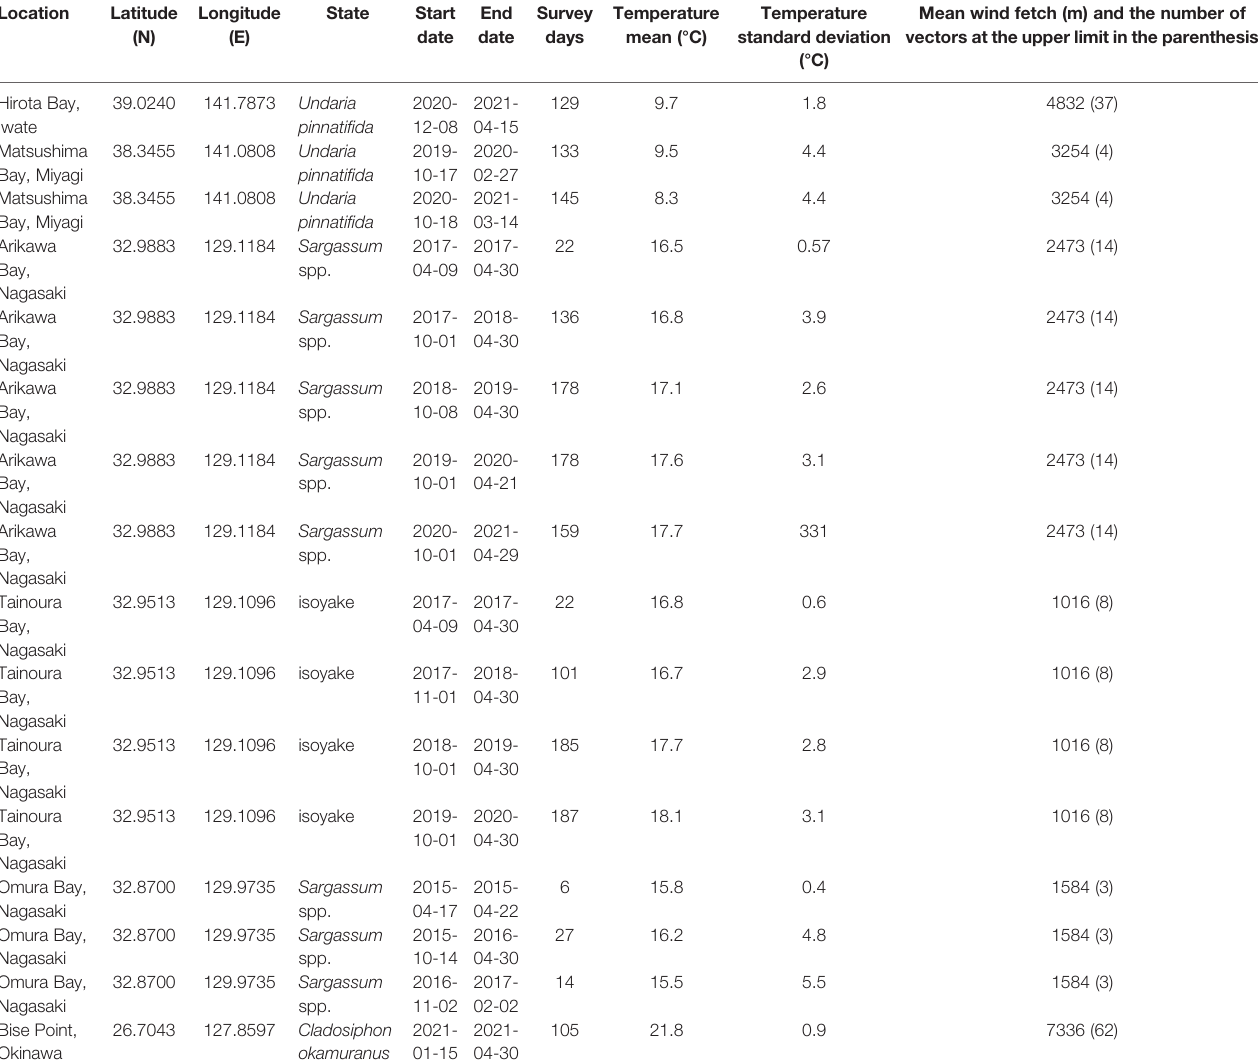
TABLE 1 | Location, state, survey period, the number of recorded days (Survey days), the mean and standard deviation of the temperature during the survey period, and the mean fetch of the study sites. Location Latitude